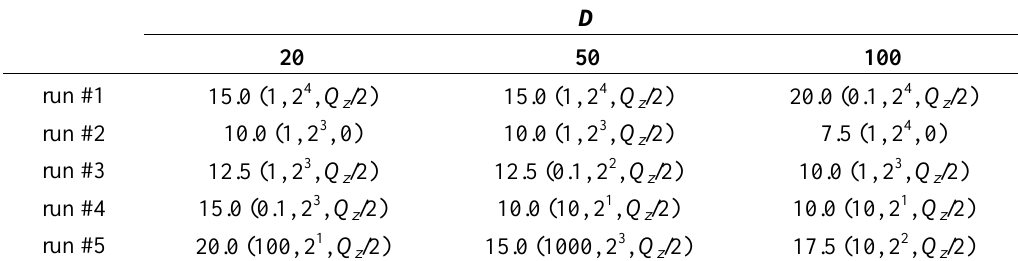
Table 6. Simulation results: problem C,